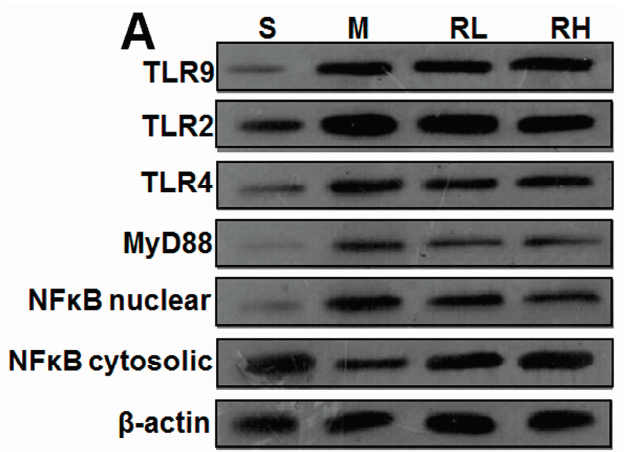
Figure 3. Effect of Rhy on the activation of TLR/NF- κ B signaling. ( A ) The expression of TLR2/4/9, MyD88 and NF- κ B at 24 h after pMCAO in Sham (S), pMCAO (M),